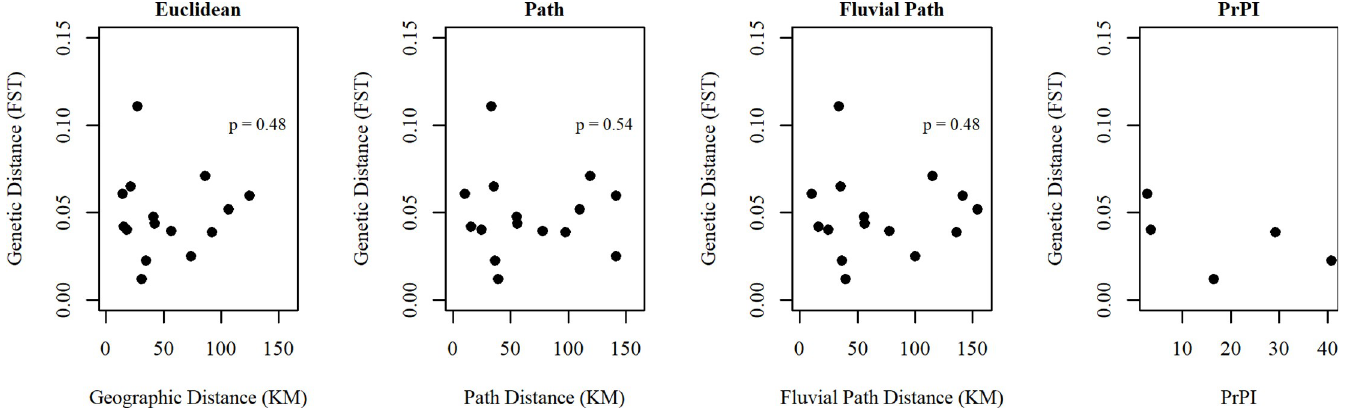
Fig 2. Isolation by distance models for three measures of geographic distance and for one measure of network distance for Iquitos and surrounding sites. A total of 15 pairwise comparisons are shown for Euclidean, Path, and Fluvial Path models. Only 5 pairwise comparisons were shown for the PrPI model, as transportation data were only available for traffic between Iquitos and surrounding towns (and not between other towns). P-values shown are Mantel probabilities.